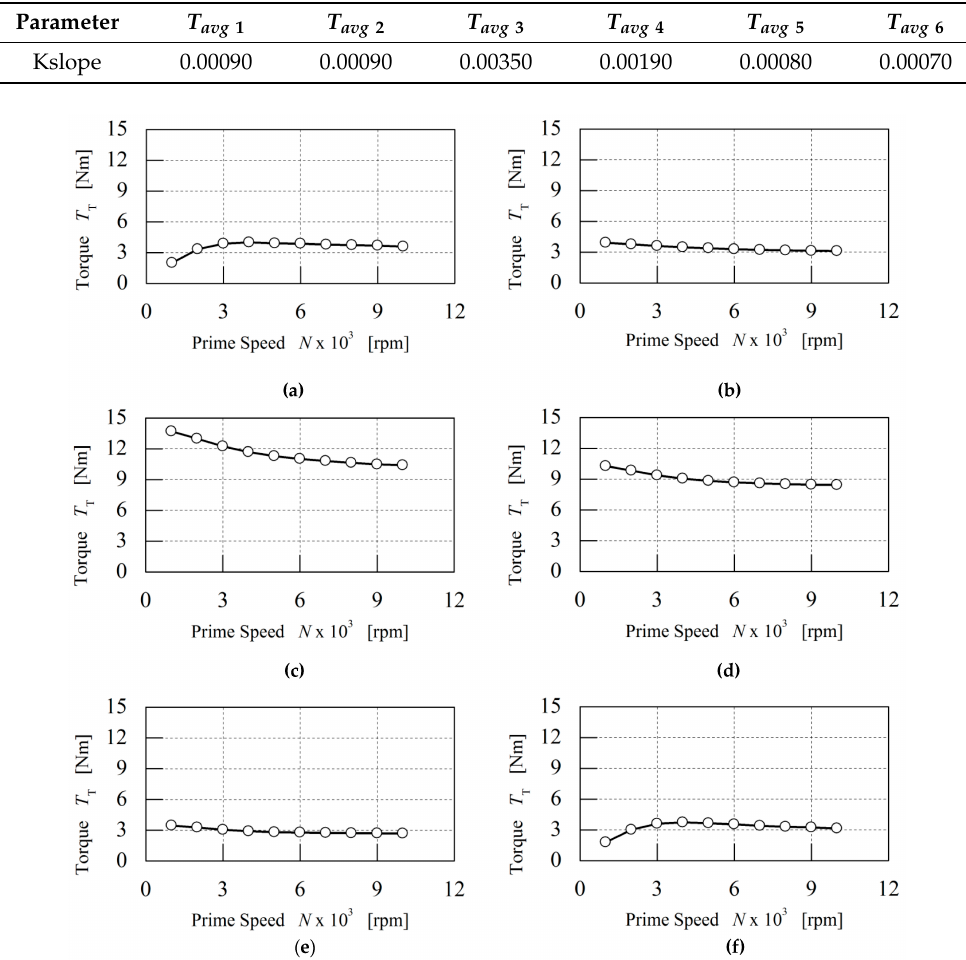
Figure 15. Torque distribution of DS-MGM without load: ( a ) Outer stator and outer field PM; ( b ) Outer field PM and outer iron ring; ( c ) Outer iron ring and prime PM; ( d ) Prime PM and outer iron ring; ( e ) Inner iron ring and inner field PM; ( f ) Inner field PM and inner stator.